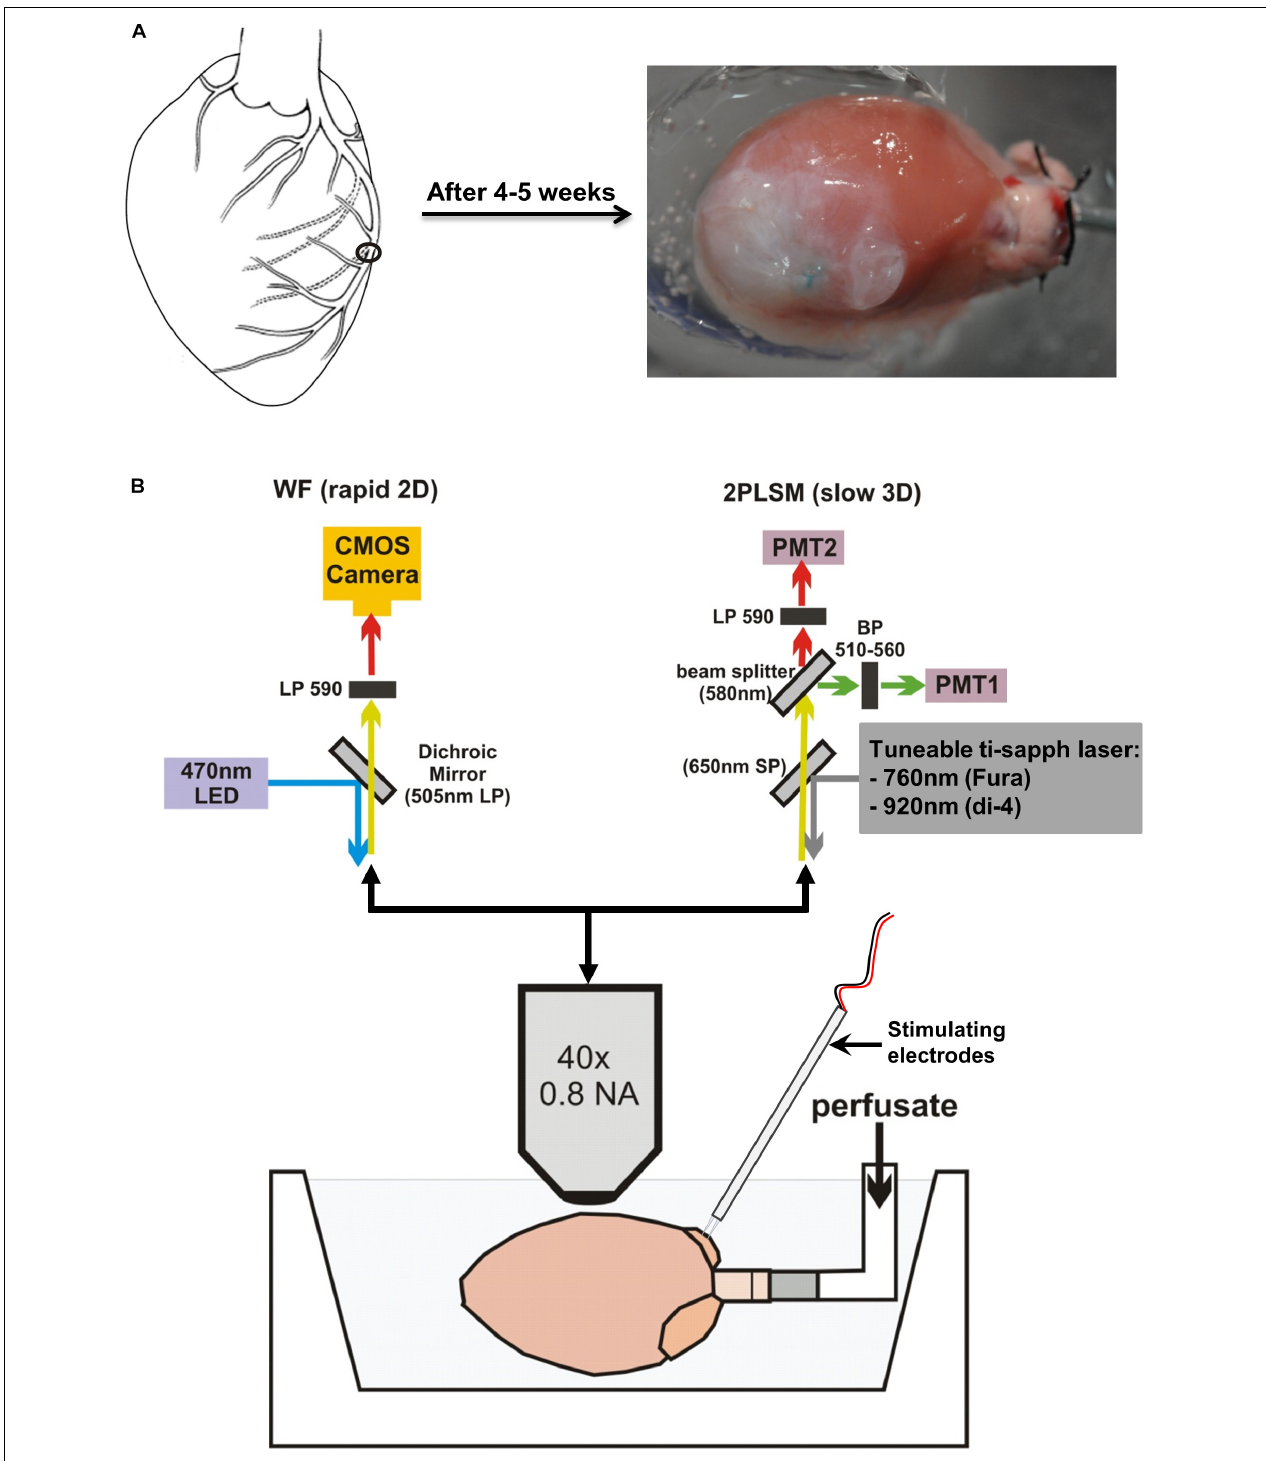
FIGURE 1 | Infarct development and microscope setup. (A) Schematic diagram showing the permanent surgical ligation performed on the left anterior descending coronary artery. Four to five weeks post-surgery, a large infarct is produced. (B) Langendorff-perfused hearts were positioned horizontally and imaged using an upright microscope. Optical settings were switched between a widefield (WF) system for rapid 2D imaging (top left) and a 2-photon laser scanning microscopy (2PLSM) system for slow 3D imaging (top right).